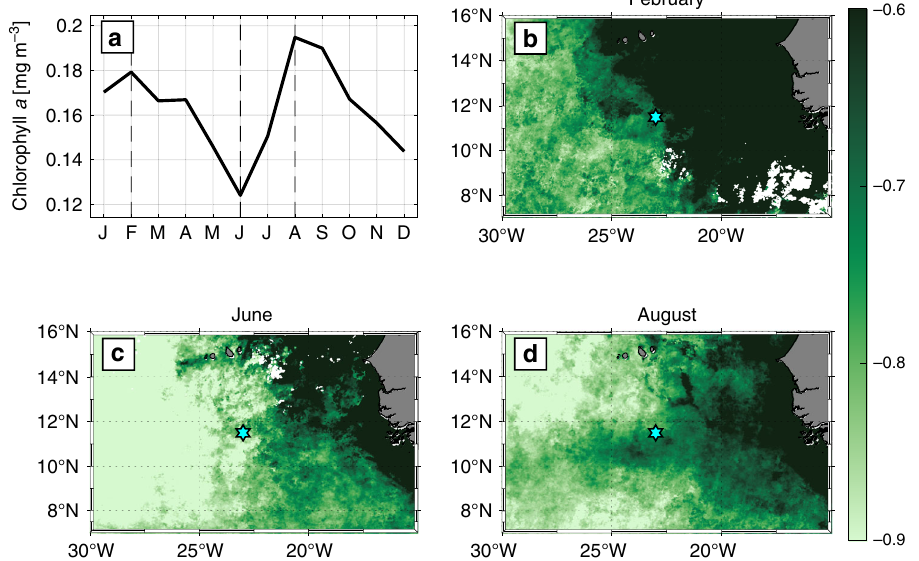
Fig. 9 Seasonal cycle of chlorophyll a in the eastern tropical North Atlantic. a Seasonal cycle of chlorophyll a averaged over a box in the vicinity of the PIRATA buoy (9°N – 11.5°N, 23 – 26°W) for the years 2002 – 2012. b – d Monthly mean (2002 – 2012) chlorophyll a distribution for the respective months February, June, and August. The PIRATA buoy position is indicated as cyan